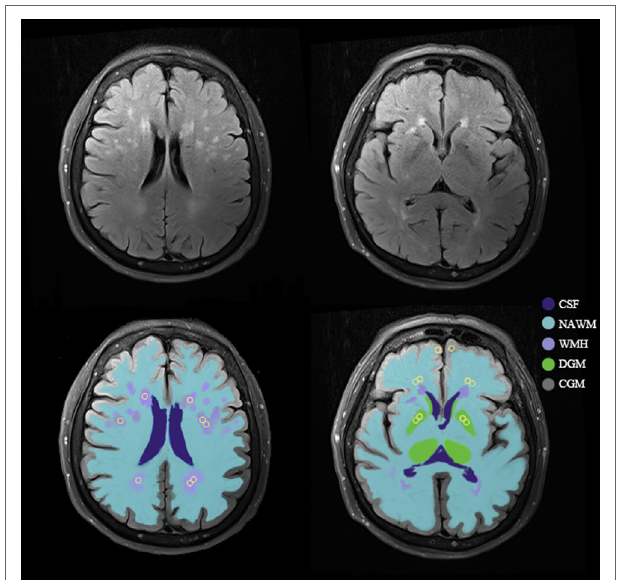
FigUre 1 | An example of tissue segmentation and regions of interest (ROIs). Example of the template for sampling ROIs (yellow circles) in normal-appearing white matter (NAWM), white matter hyperintensities (WMH), cortical gray matter (CGM), and deep gray matter (DGM). Abbreviation: CSF, cerebrospinal